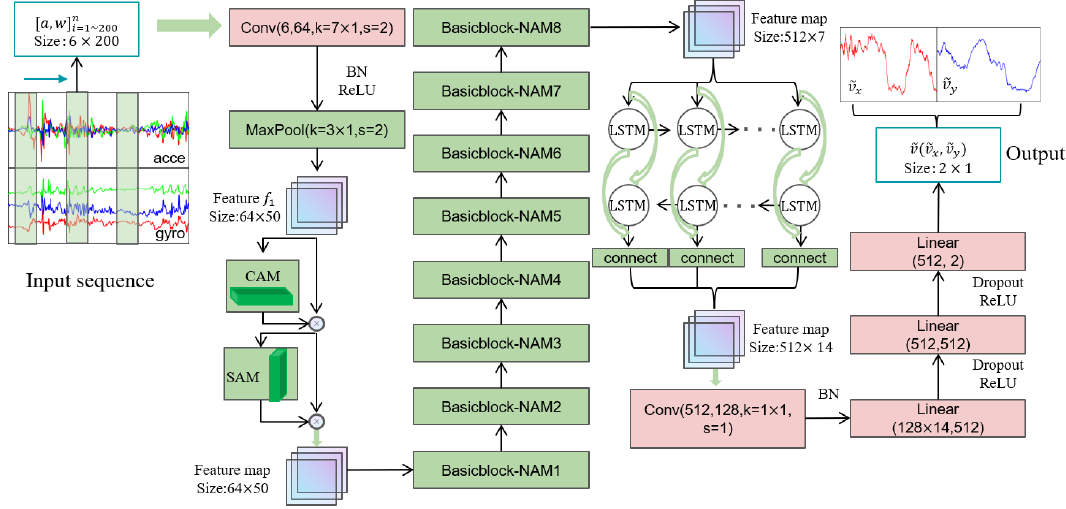
Figure 4. RBCN-Net